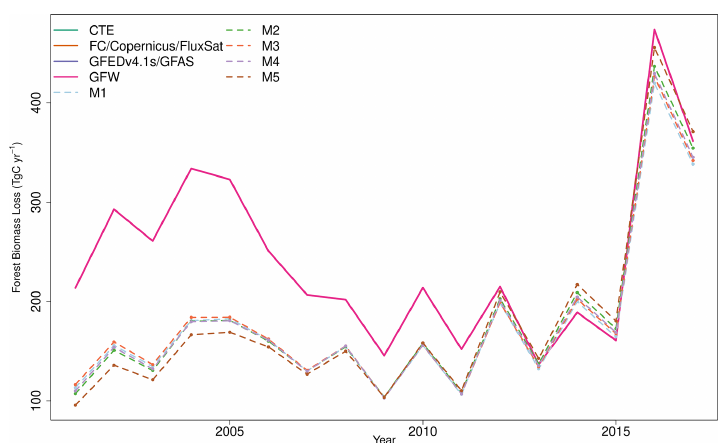
Figure A11. Comparison of DALEC-estimated forest biomass